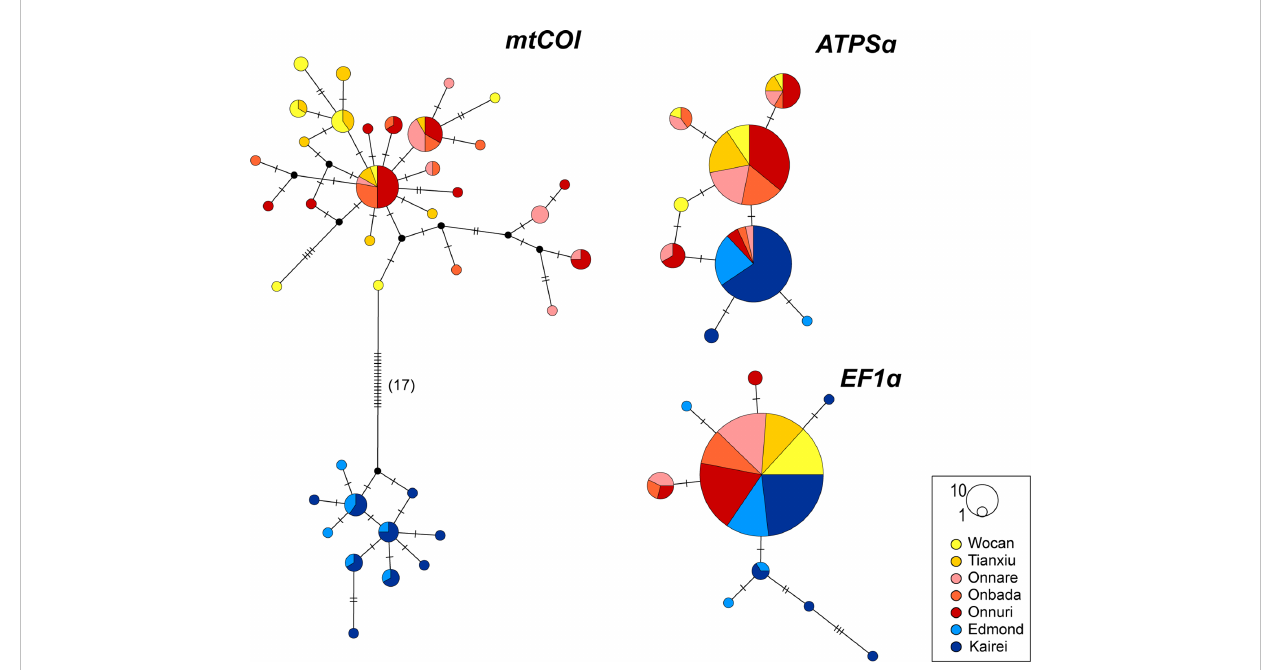
FIGURE 3 Median-joining network of mtCOI , ATPS a and EF1 a genes. Each circle represents a distinct haplotype or allele, and its size is proportional to the frequency. Colors in the circle are consistent with the colors of vent fi elds on the map in the Figure 1. Black circle is the hypothetical haplotype. Hatch mark represents a single nucleotide mutation.